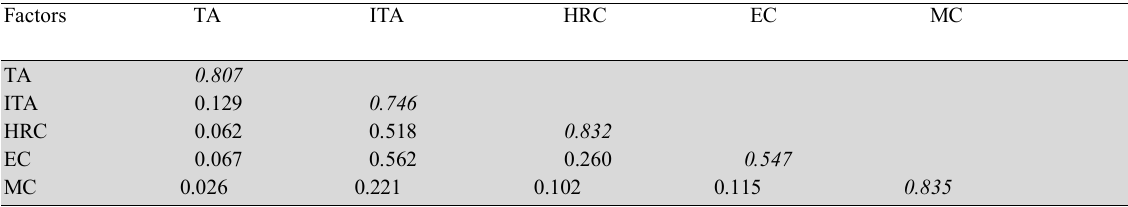
Discriminant validity analysis for RBV